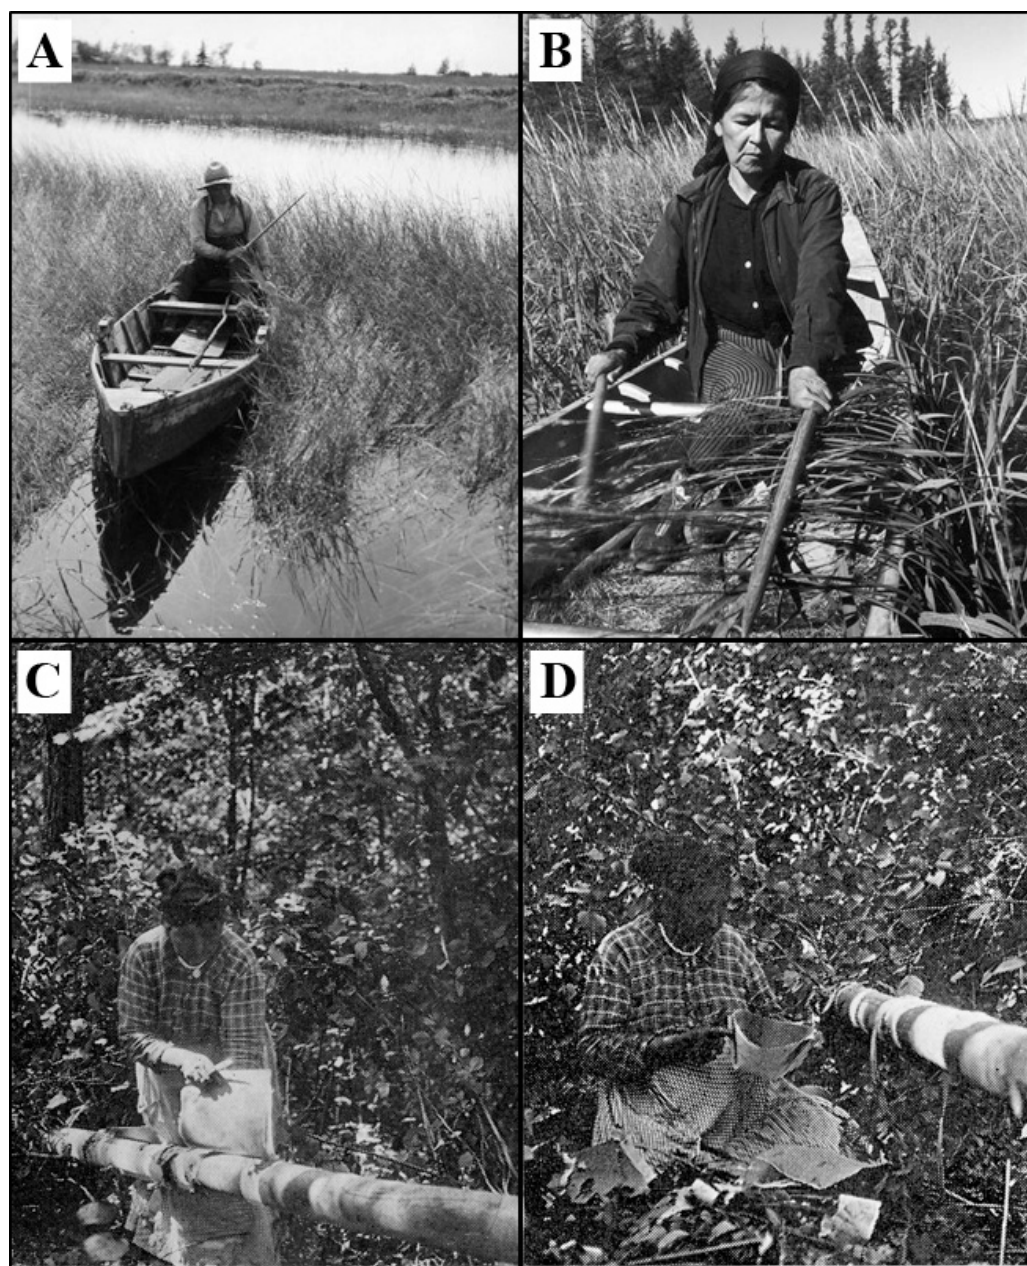
Fig. 3. Elements of traditional Ojibwe interactions with the northern Great Lakes environment. (A) “Joe Stoddard of the Chippewa Tribe harvests wild rice on the Bad River Indian Reservation.” Photograph by